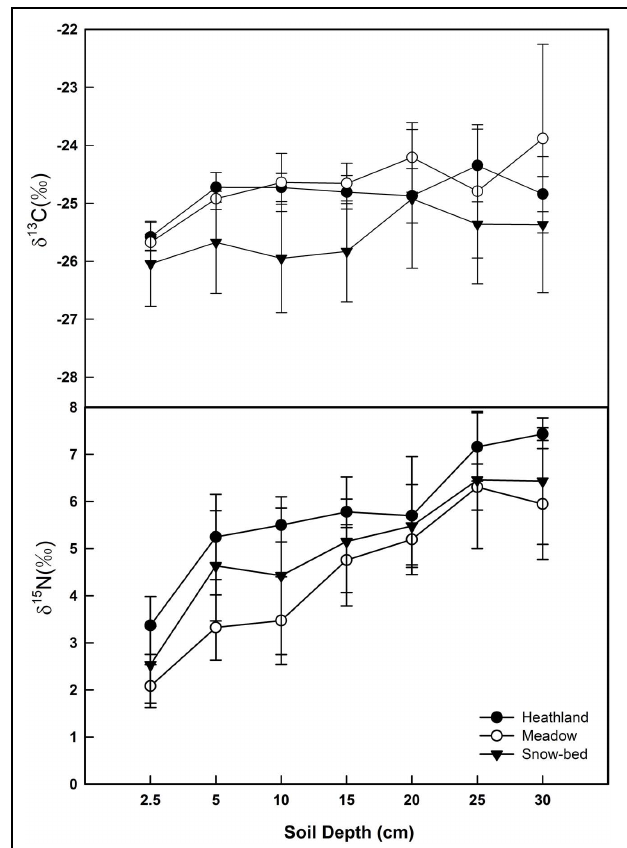
FIGURE 8 | Soil profiles of δ 13 C and δ 15 N in the three alpine plant communities (mean ± SE, n = 4 soil samples per community type). While no significant effects of soil depth on δ 13 C, δ 15 N increased significantly with soil depth ( p <